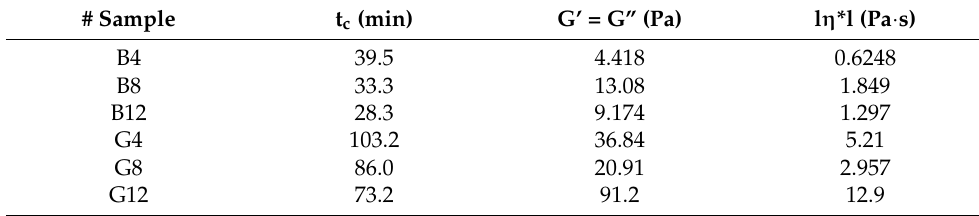
Figure 4. Comparative time sweep rheological test of ( a ) CD-PEG and ( b ) CDLA-PEG hydrogels syntheses. Table 2. The calculated time test parameters for